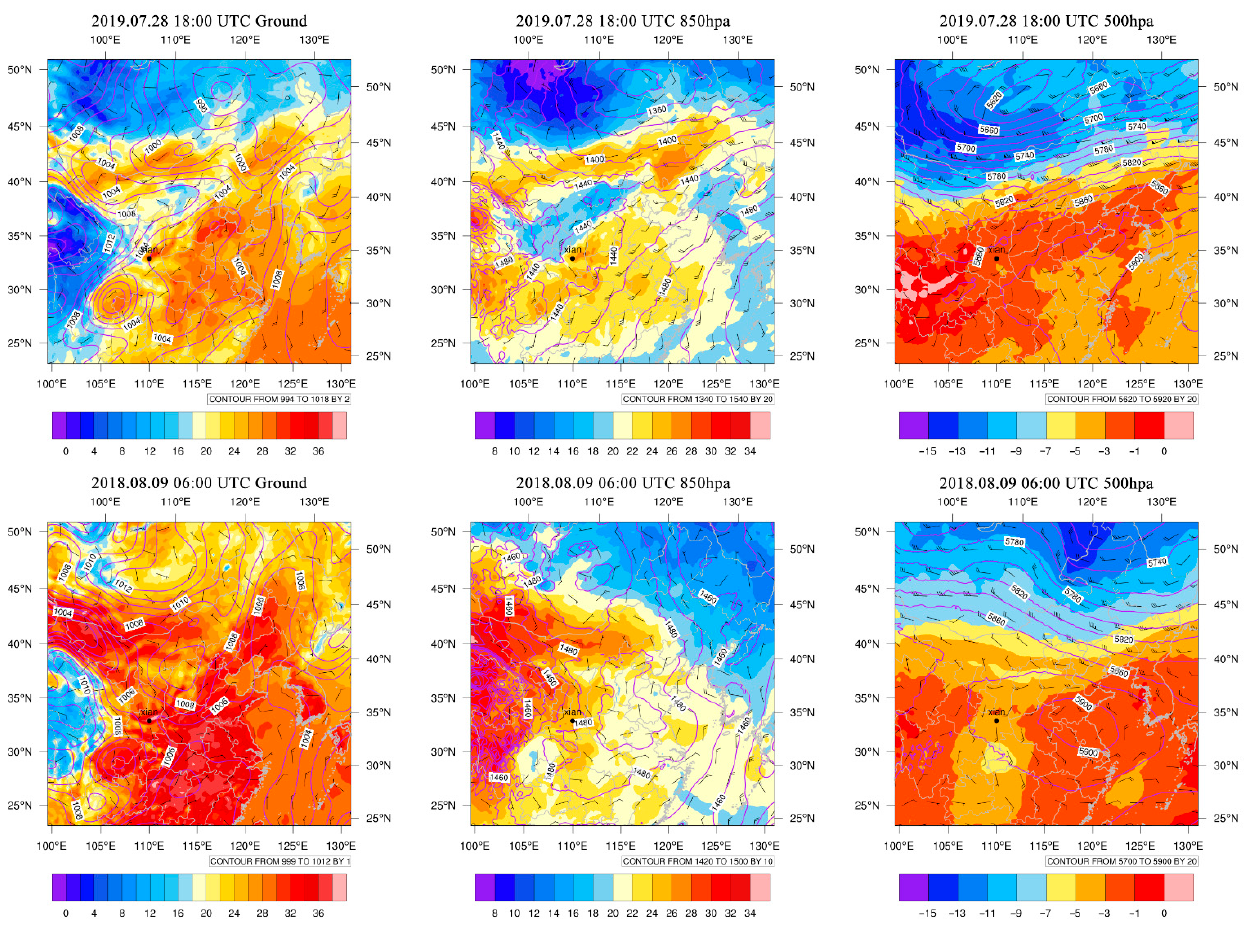
Figure 3. Weather map of the initial field of ground, 850 hPa, and 500 hPa isobaric pressure surfaces during the two precipitation events. The black line represents the horizontal wind field, the purple contour line represents the potential height (m), the ground plot is the sea level pressure field (hpa), and the color indicates the temperature (°C).